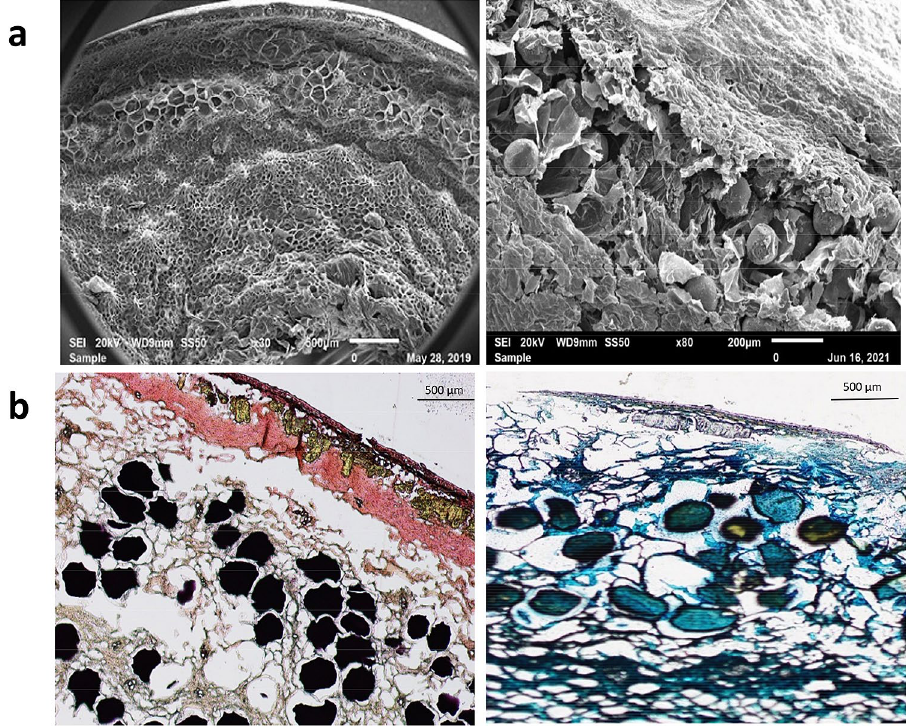
Figure 2. Localization of melanin in mature date fruits, ( a ) Scanning electron microscopic (SEM) image showing the tanniferous cells between the outer and inner mesocarp, and ( b ) Light microscopic images stained with 4-dimethyl amino cinnnamaldehyde (DMACA, left) and ferric chloride/potassium ferric cyanide (right) showing the presence the localization of melanin/proanthocyanidins in the tanniferous cells